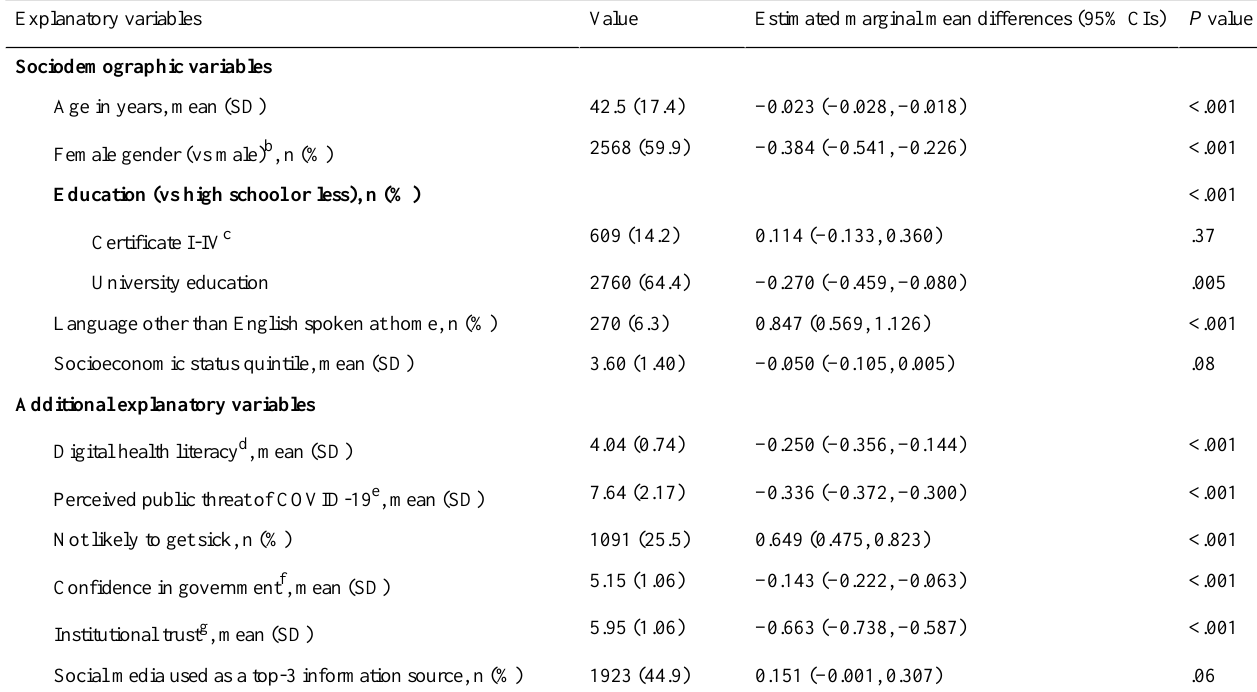
Table 3. Multivariable truncated linear regression of strength of agreement with misinformation beliefs at Round 1 a . Higher values of the outcome indicate greater support for